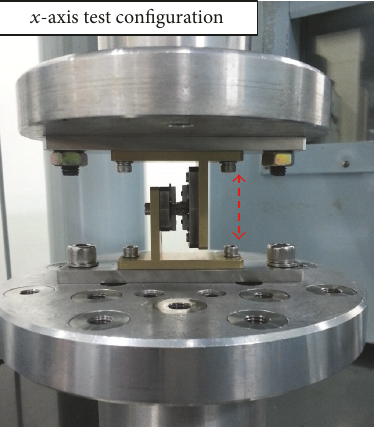
Figure 4: Representative static loading test configuration of the ring-type SMA mesh washer along with 𝑥